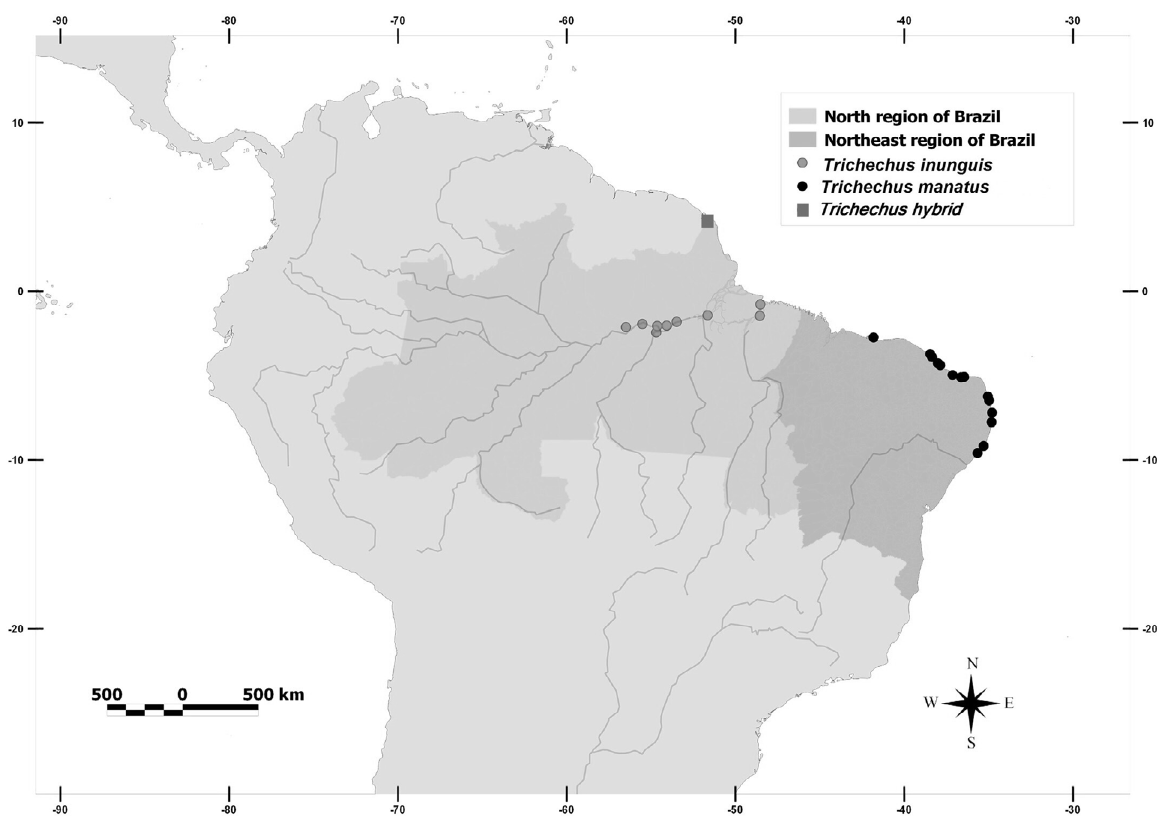
Figure 1 – Map indicating the respective geographic collection sites of the manatees in North and Northeast regions of